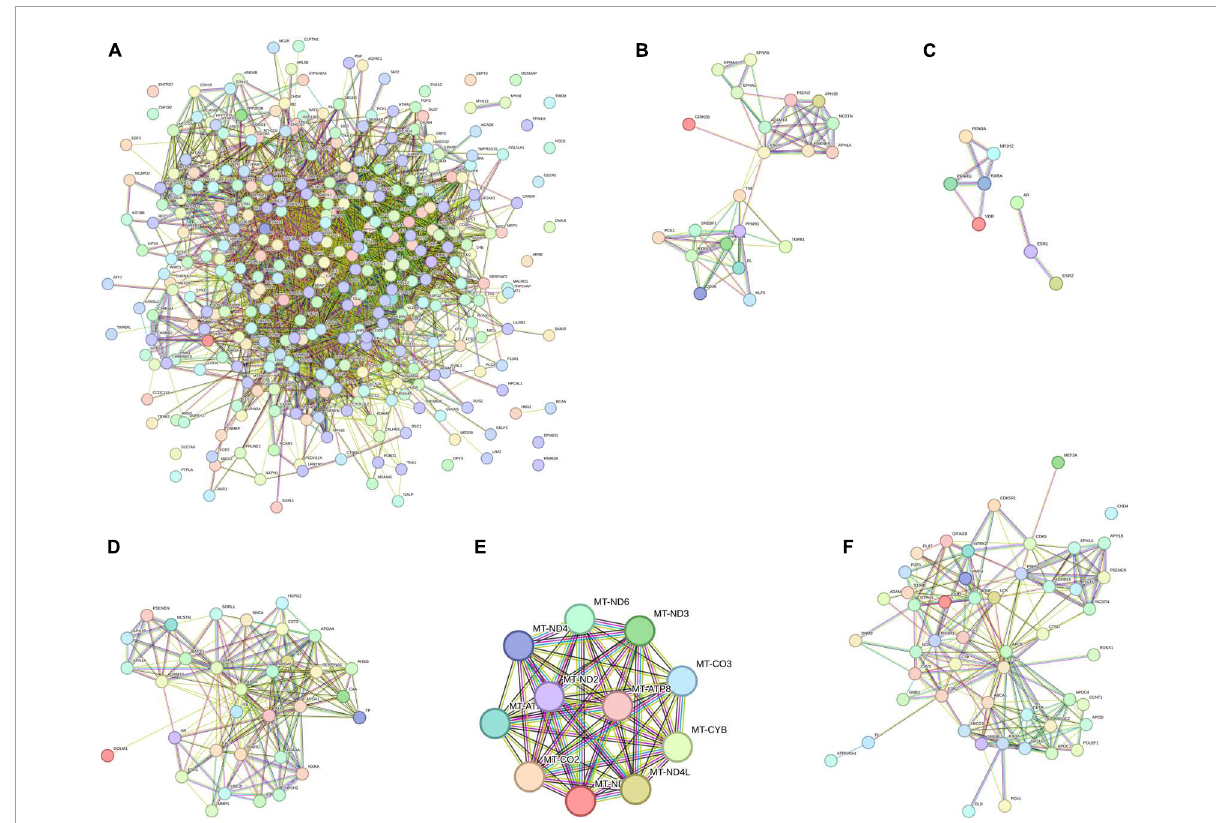
FIGURE1 Interaction network pathways of new biological hallmarks. (A) Network display of all AD genes. (B) Developmental Biology (axon and adipose development); (C) gene expression (RNA polymerase II transcription); (D) metabolism of proteins (Amyloid formation, regulation of IGF-1/Insulin, and small ubiquitin-like modifiers/SUMOs); (E) metabolism of RNA (mitochondrial tRNA and rRNA processing); (F) signal Transduction (ErbB, NOTCH, and p75 NTR death signaling). The interaction network was created by STRING-DB. Node colors are for visual only. Edge colors are as follows: blue: from the curated database; pink: experimentally determined; black: co-expression; green: text mining.